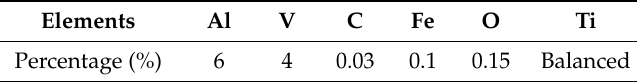
Table 1. Composition of Ti64